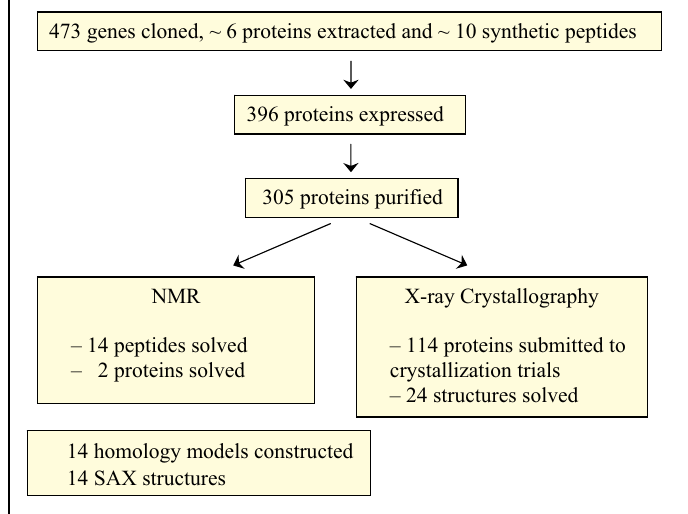
Fig. 1 – The SMolBNet pipeline showing the general achievements at the end of the fourth year.